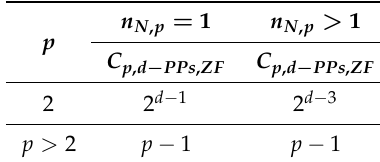
Table 7. The values C p , d − PPs for d -PPs ( d ≥ 3) fulfilling Zhao and Fan (ZF) sufficient conditions. C p , ( d − 1 ) − PPs n N , p = 1 n N , p > p